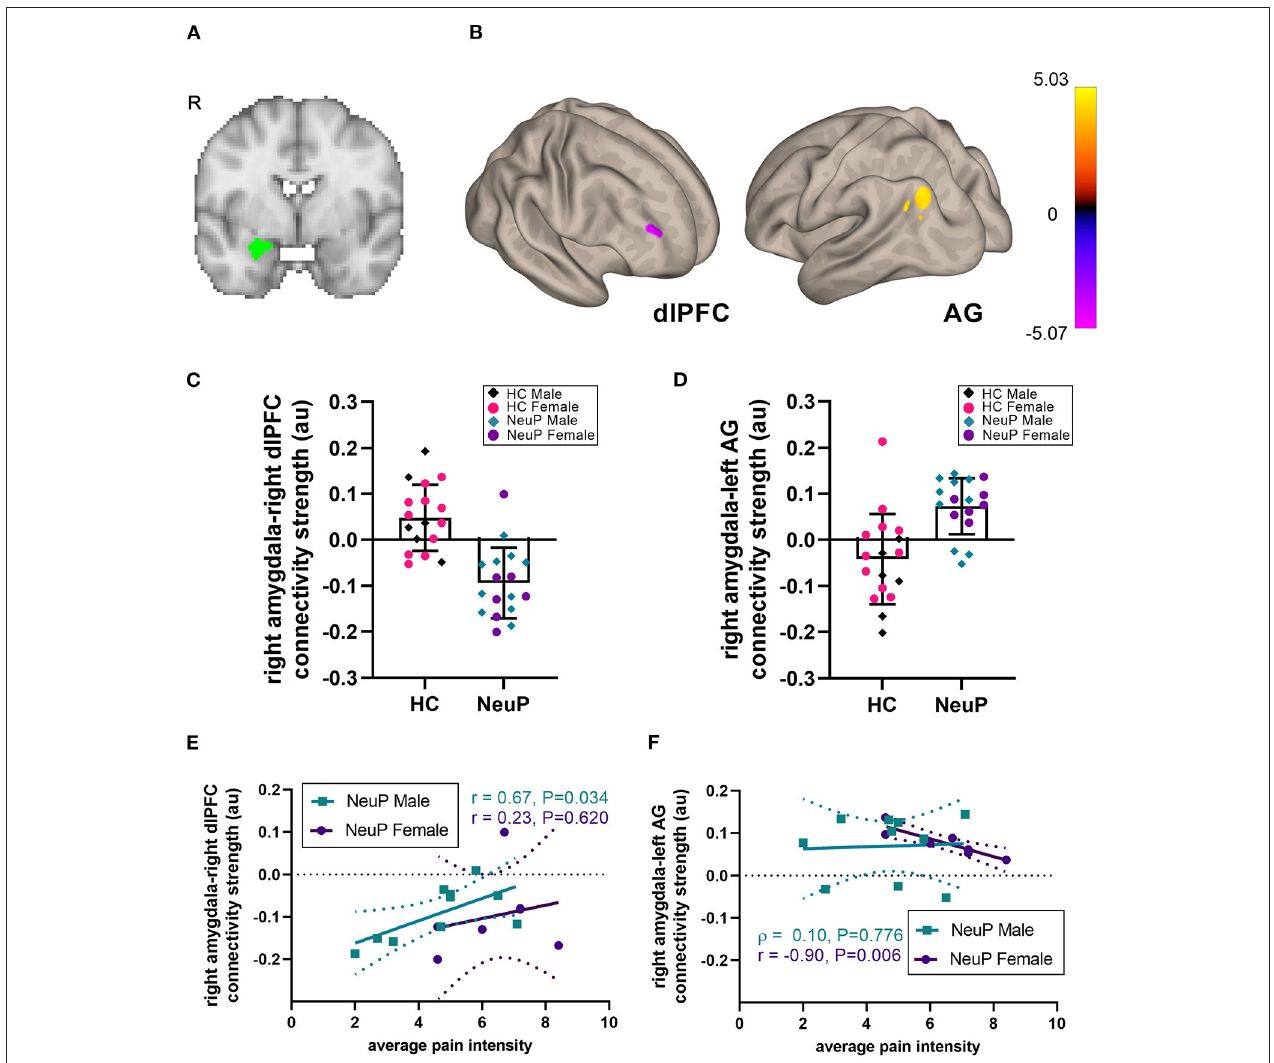
FIGURE 1 | Right amygdalar rsFC network in adolescents with NeuP compared to control participants. (A) Location of the right amygdala seed. (B) We observed decreased amygdalar resting-state functional connectivity (rsFC) to the right dorsolateral prefrontal cortex (dlPFC), and increased rsFC to the left angular gyrus (AG), in patients compared to healthy controls (HC), significant at cluster-corrected P FDR < 0.025. (C) Individual participant rsFC values between the right amygdala and the dlPFC, plotted separately for male and female NeuP patients and HC. (D) Individual participant rsFC values between the right amygdala and the left AG. (E) In male patients with NeuP, pain intensity positively correlated with the right amygdala-right dlPFC rsFC. (F) In female patients with NeuP, pain intensity negatively correlated with the right amygdala-left AG rsFC. (C,D) Data points represent individual values; bars represent mean [SD]. (E,F) Data points represent individual values; solid line represents regression line for correlation; dotted lines represent 95% confidence interval. au, arbitrary units; HC, healthy control; NeuP, neuropathic pain; R, right hemisphere; r, Pearson correlation; ρ , Spearman correlation.